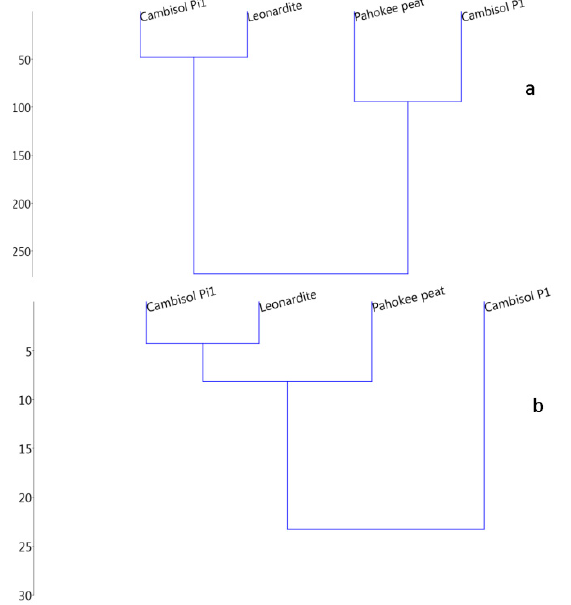
Figure 4. The clusters of four mineral soils with differing chemical composition are shown as a function of the thermodynamics state variables ( a ) and as a function of the microbial diversity data in Table 5 ( b ).